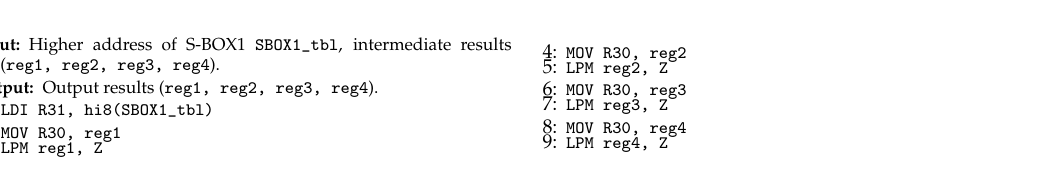
Algorithm 1 Optimized four S-BOX1 accesses in a source code level.